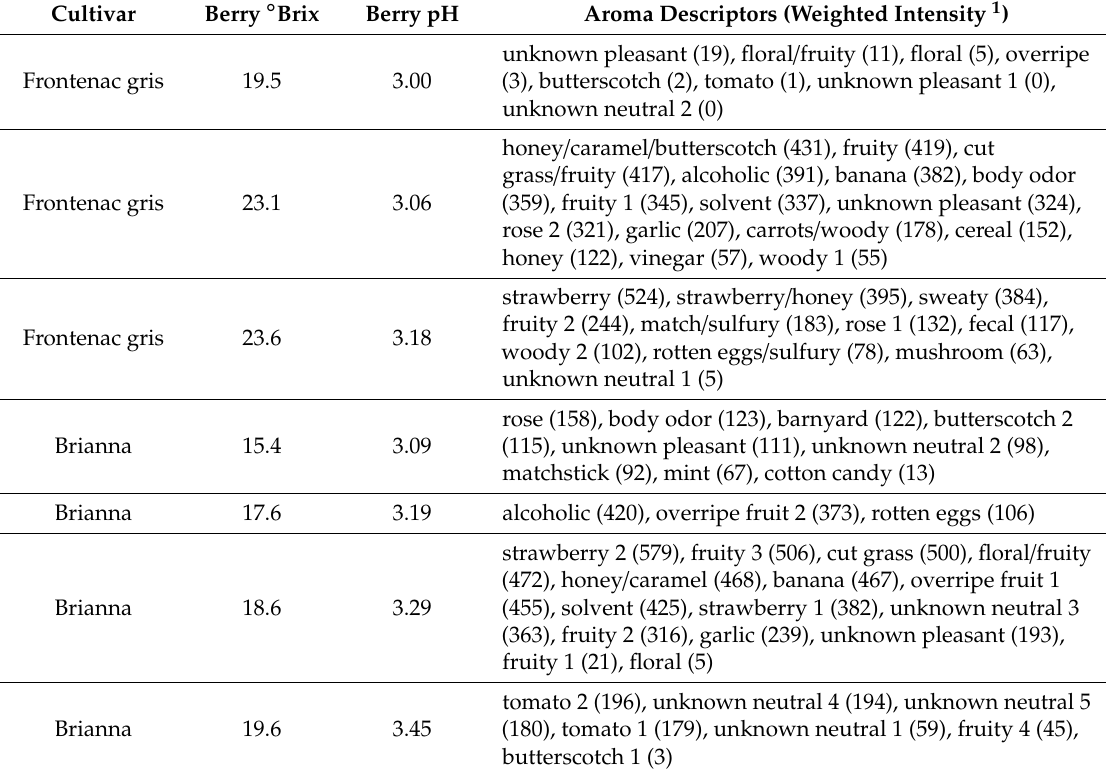
Table 3. Summary of the ranked weighted intensity of aromas (recorded by olfactometry) in wine made from Frontenac gris and Brianna grapes harvested at di ff erent stages of ripening. All juice was brought to 24 ◦ Brix for Frontenac gris and 20 ◦ Brix for Brianna prior to fermentation to ensure similar alcohol content in the wines from the di ff erent time